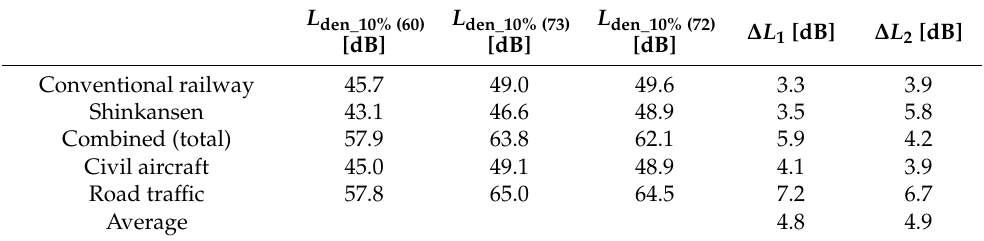
Table 4. Averages of ∆ L 1 and ∆ L 2 derived from exposure–response relationships estimated for each noise source.